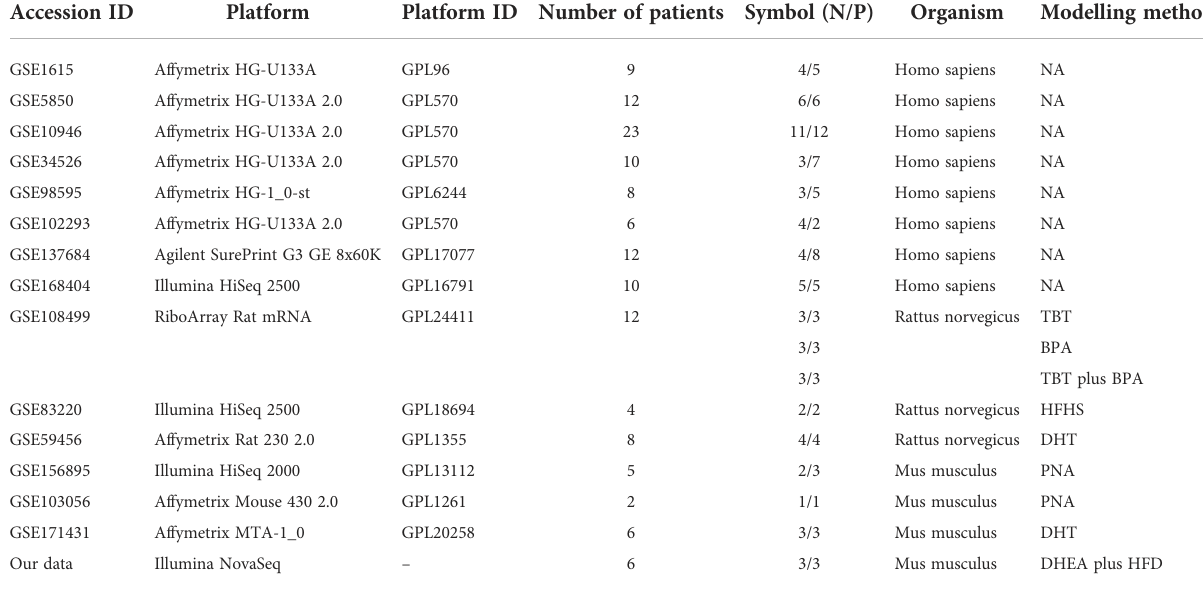
TABLE 1 Details of microarray and RNA-seq